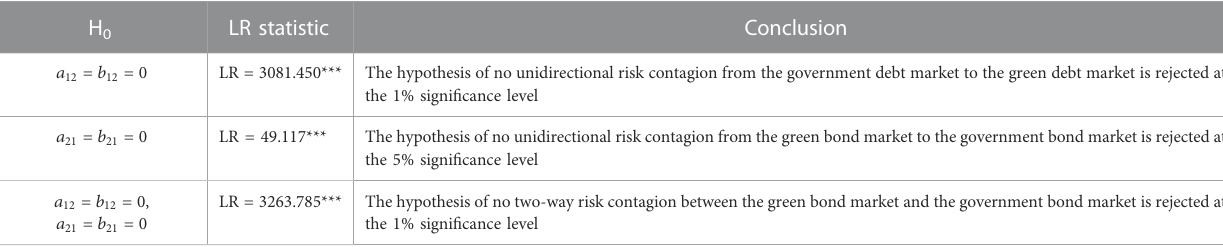
TABLE 8 Test of risk contagion effects between green bonds and the government bond market. H